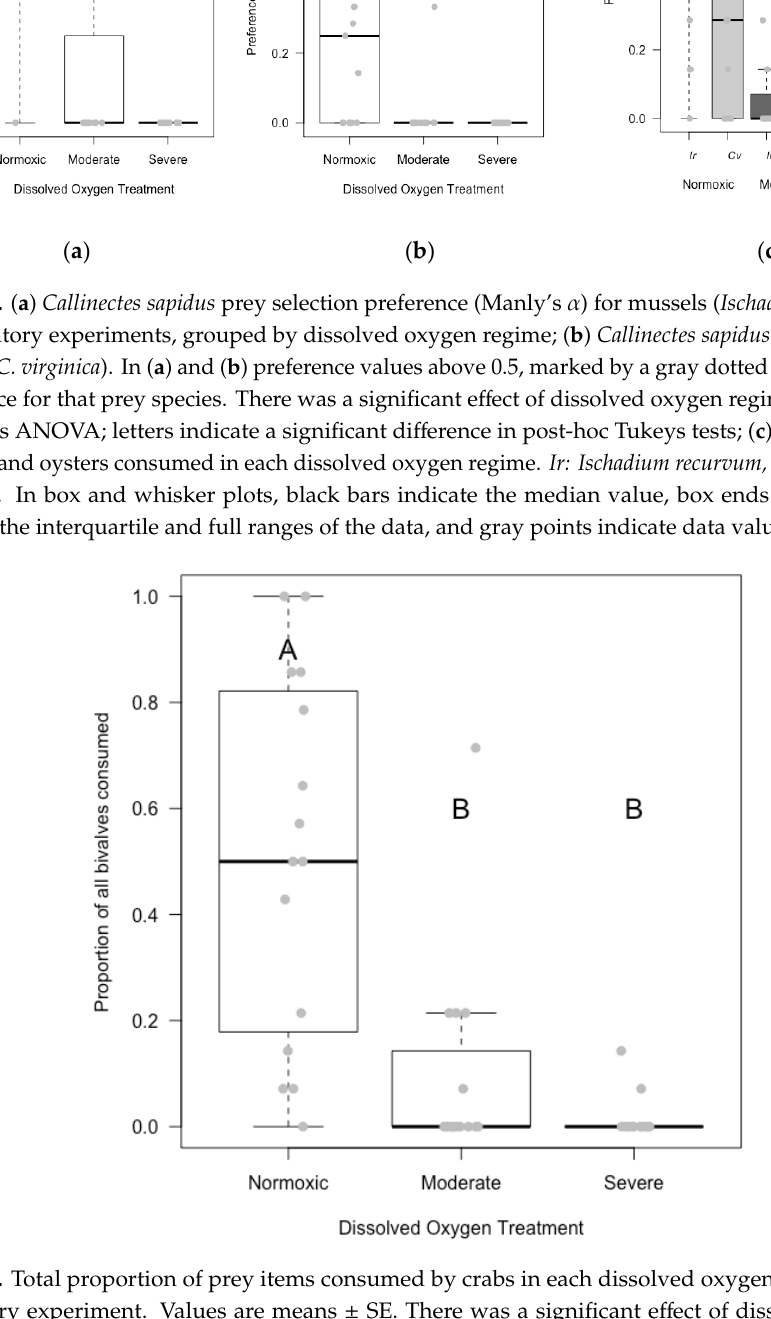
Figure 5. Total proportion of prey items consumed by crabs in each dissolved oxygen regime in the laboratory experiment. Values are means ± SE. There was a significant e ff ect of dissolved oxygen regime in repeated measures ANOVA; letters indicate a significant di ff erence in post-hoc